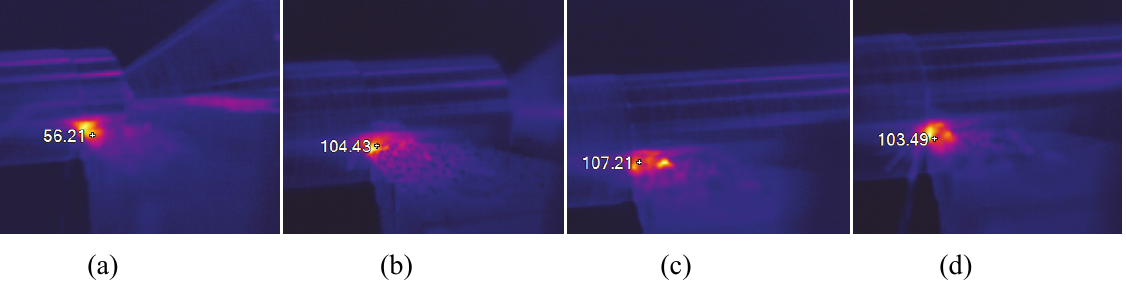
Fig. 5. Infrared thermal images during turning in dry environment at (a) Run 1; (b) Run 7; (c) Run 11; and (d) Run 16